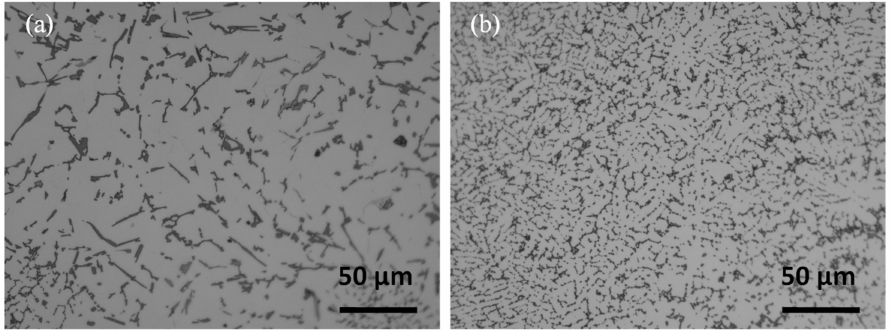
Figure 3. Microstructures of the Al-7Si-0.3Mg alloy strips fabricated using RSF (role separating force) values of ( a ) 3 kN and ( b ) 20